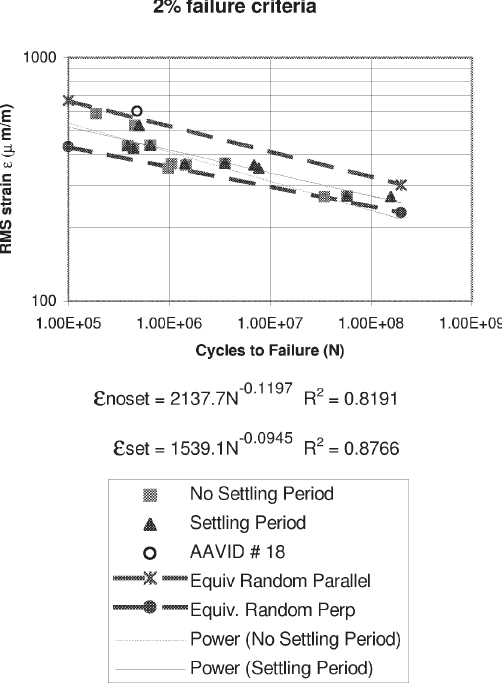
Fig. 5. MCHEX " – N curve for channels parallel to the coupon